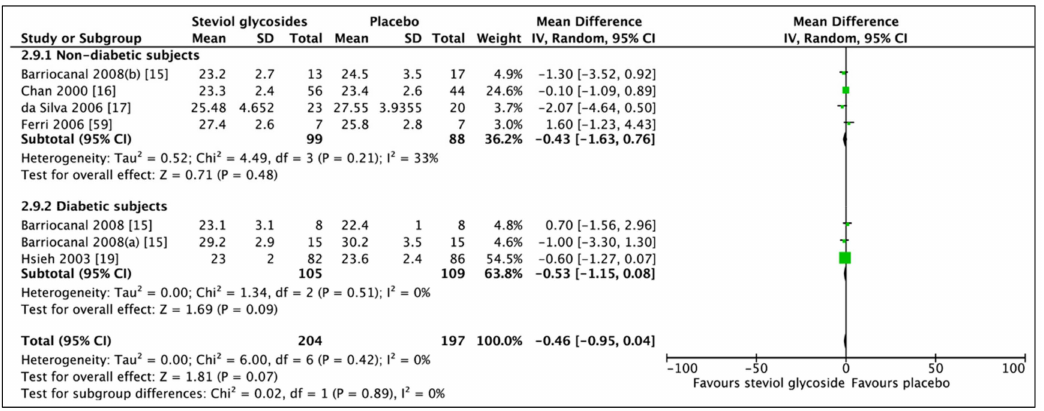
Figure 4. E ff ect of SGs on BMI (kg / m 2 ) CI: confidence interval; MD: mean di ff erence; RCTs: randomized controlled trials; SD: standard